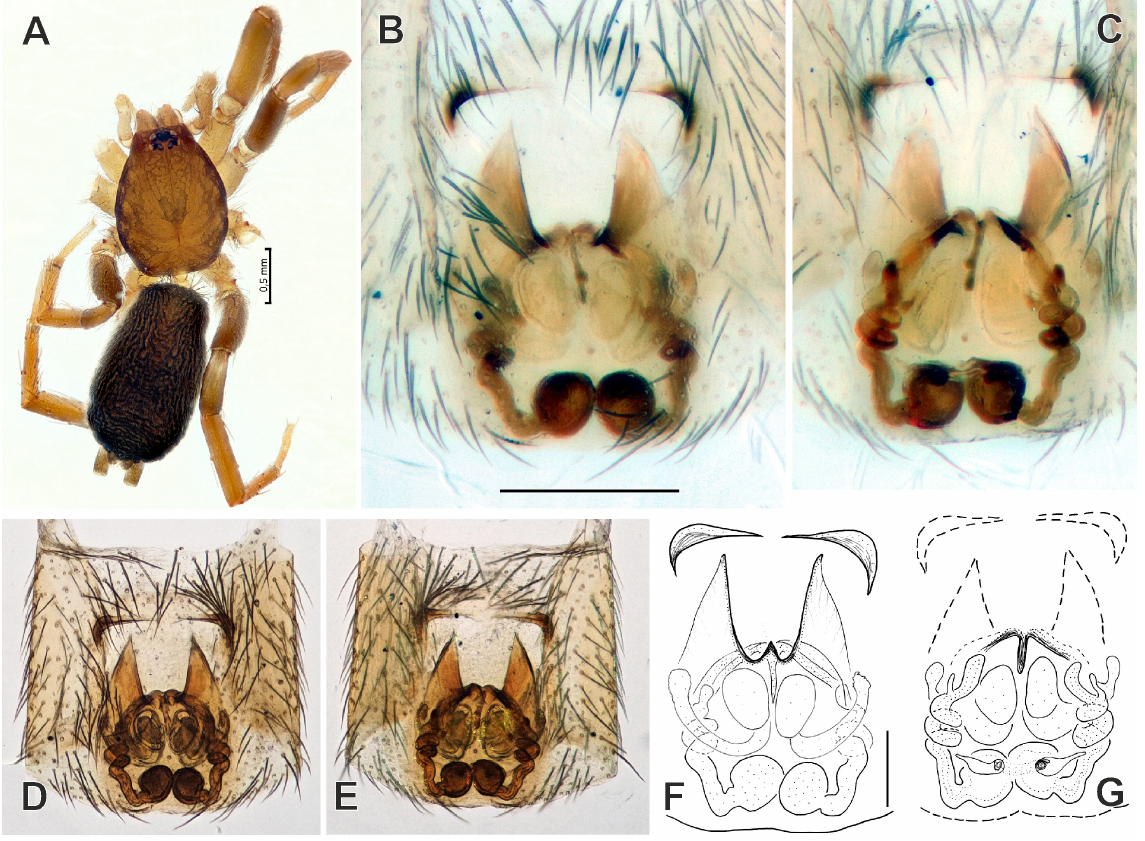
Fig. 16. Marjanus isfahanicus sp. nov., holotype, ♀ (MHNG). A . Habitus, dorsal view. B, D, F . Epigyne, ventral view. C, E, G . Epigyne, dorsal view. Scale bars: A = 0.5 mm; B = 0.2 mm; F–G = 0.1